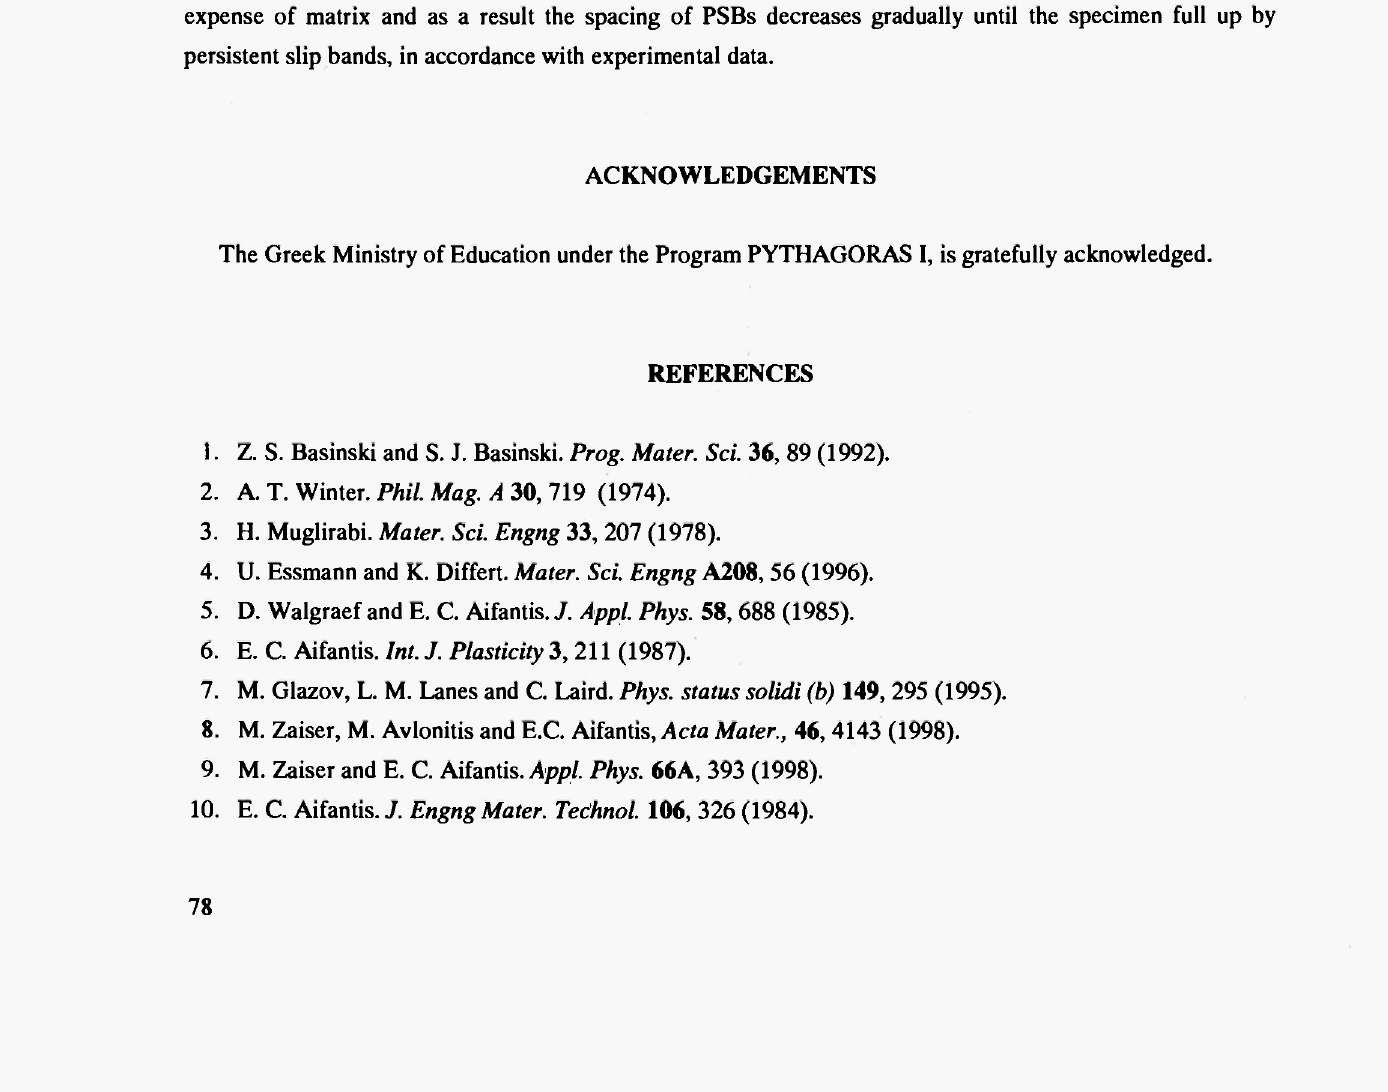
Fig. 4: Spacing of Persistent Slip Bands. Fig (4) represents the theoretically estimated dependence of PSBs spacing to the externally imposed strain amplitude. It can be seen that for increasing external strain amplitude the number of PSBs increases at the expense of matrix and as a result the spacing of PSBs decreases gradually until the specimen full up by persistent slip bands, in accordance with experimental